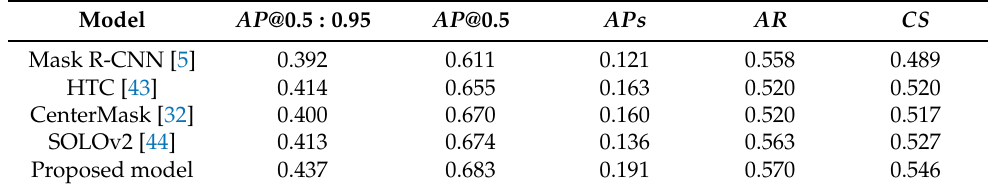
Table 3. Comparison of different network extraction methods on the self-annotated building instance segmentation dataset.The best results are highlighted in